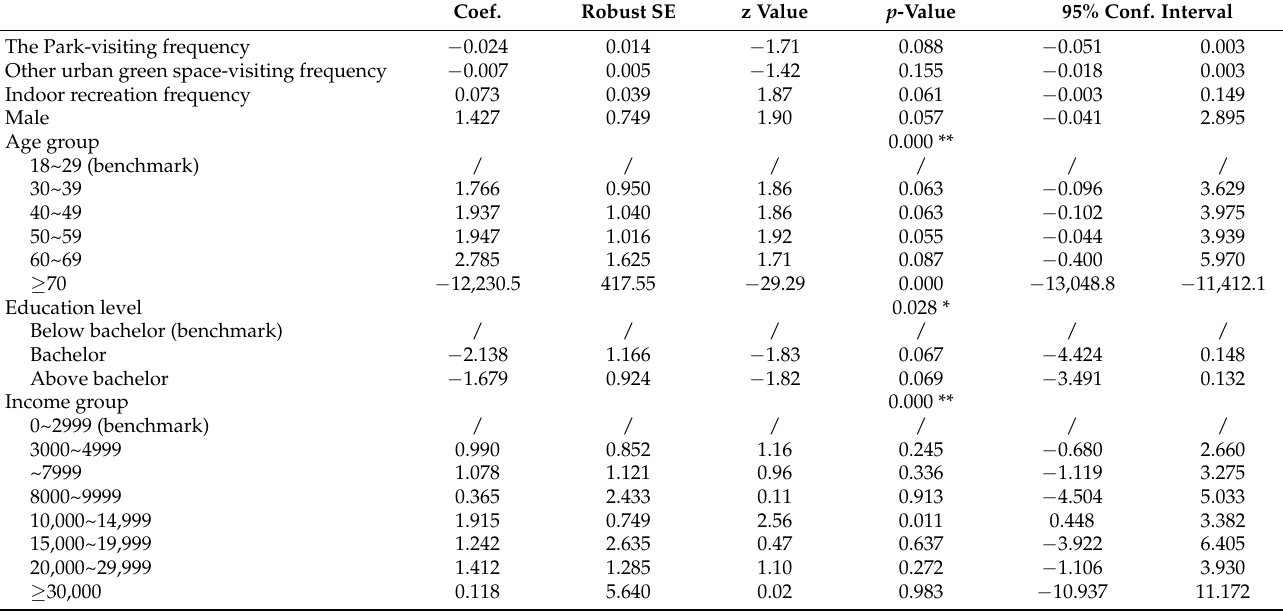
Table 4. Results from Het-Probit regression on BMI (normal/overweight). Coef. Robust SE z Value p -Value 95% Conf.